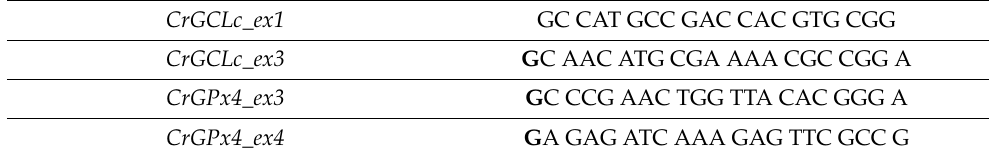
Table 1. gRNA guides used in the